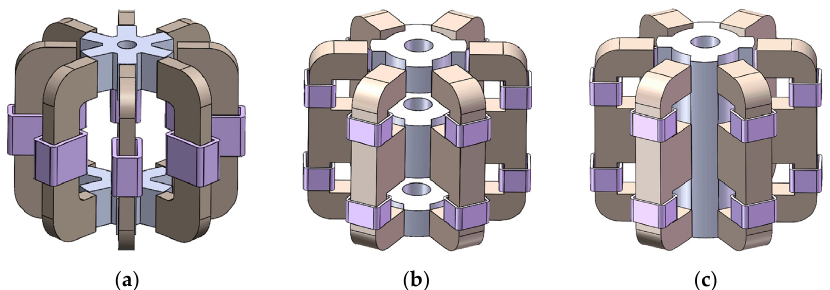
Figure 17. The model of SRM with segmental stators. ( a ) is 8/6 with C-shape segmental stators; ( b ) is 6/4 with E-shape segmental stators and triple axial segmental rotor; ( c ) is 6/4 with E-shape segmental stators which used solid axial rotor.